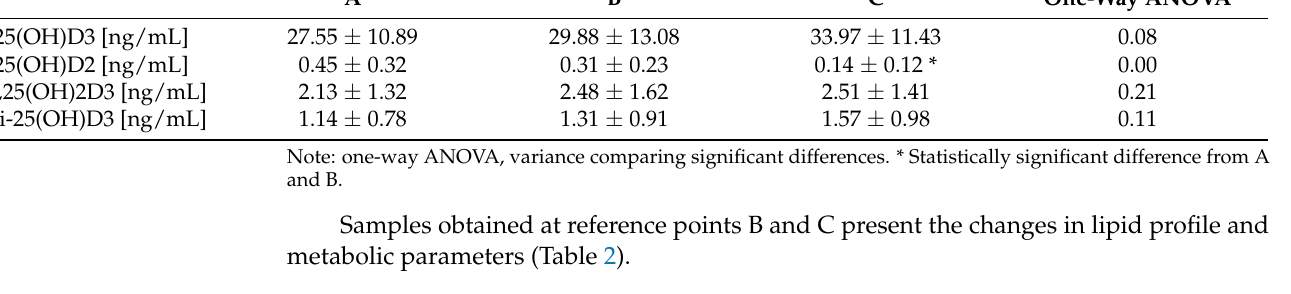
Table 2. Biochemistry—analyzed data reference points: B vs.